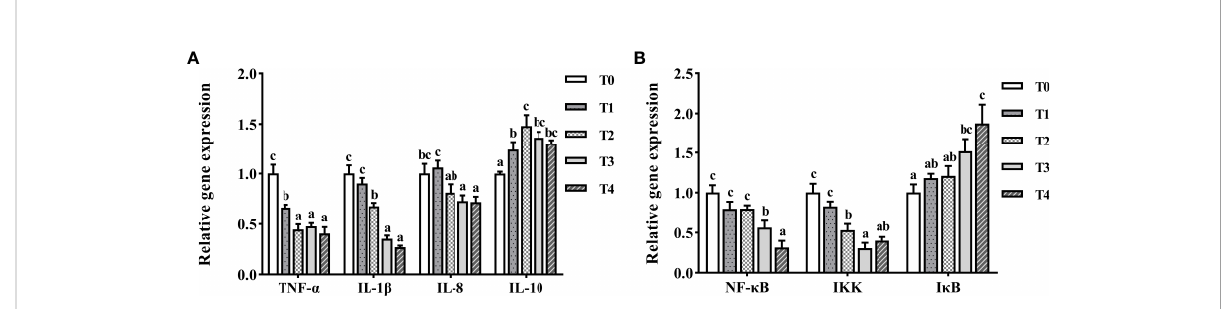
FIGURE 8 The expression pro fi les of in fl ammatory genes (A) and signaling pathway (B) in the intestine of T. ovatus fed diets with different dose taurine supplementation after 8 weeks. Mean values (n = 9) within values in the picture above with different superscripts are signi fi cantly different ( P < 0.05).